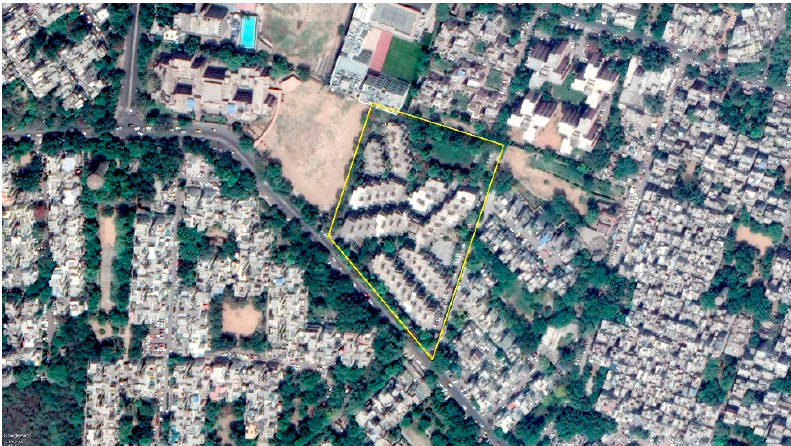
Figure 2. Satellite image of the Yamuna Apartments complex located in the Alaknanda neighbourhood of south-east Delhi (Image courtesy of Google Earth).